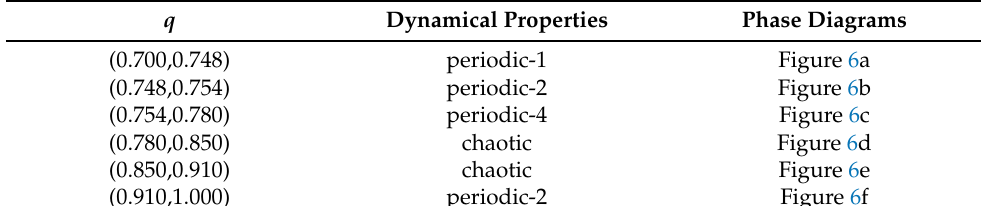
Figure 5. Dynamical behaviors with fractional orders q of system (15). ( a ) Bifurcation diagram; ( b ) LEs. Table 2. Dynamical behaviors of system (15) as the order q changes.